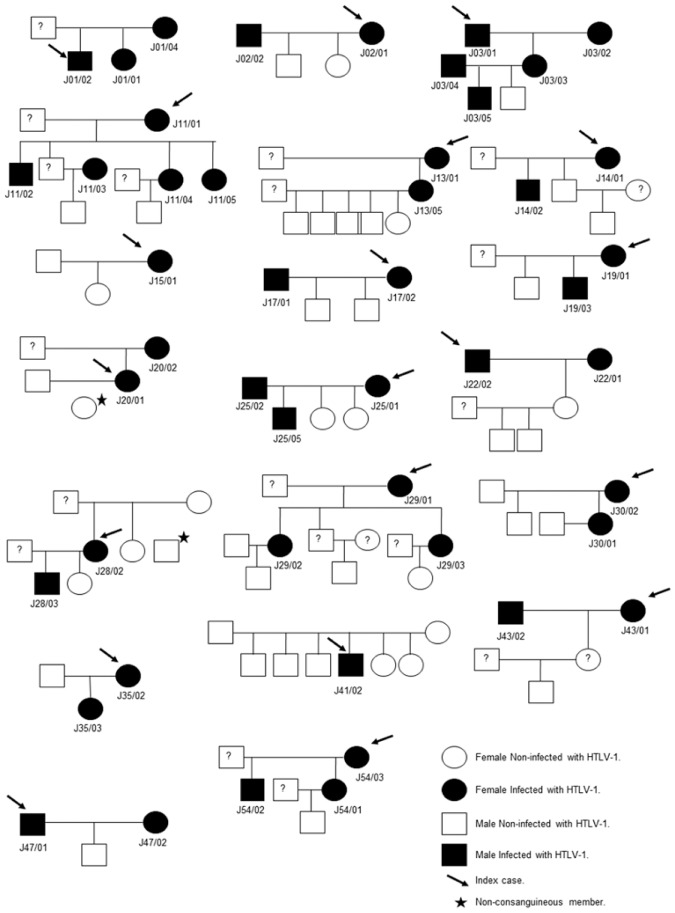
Family tree of index cases infected with HTLV-1.